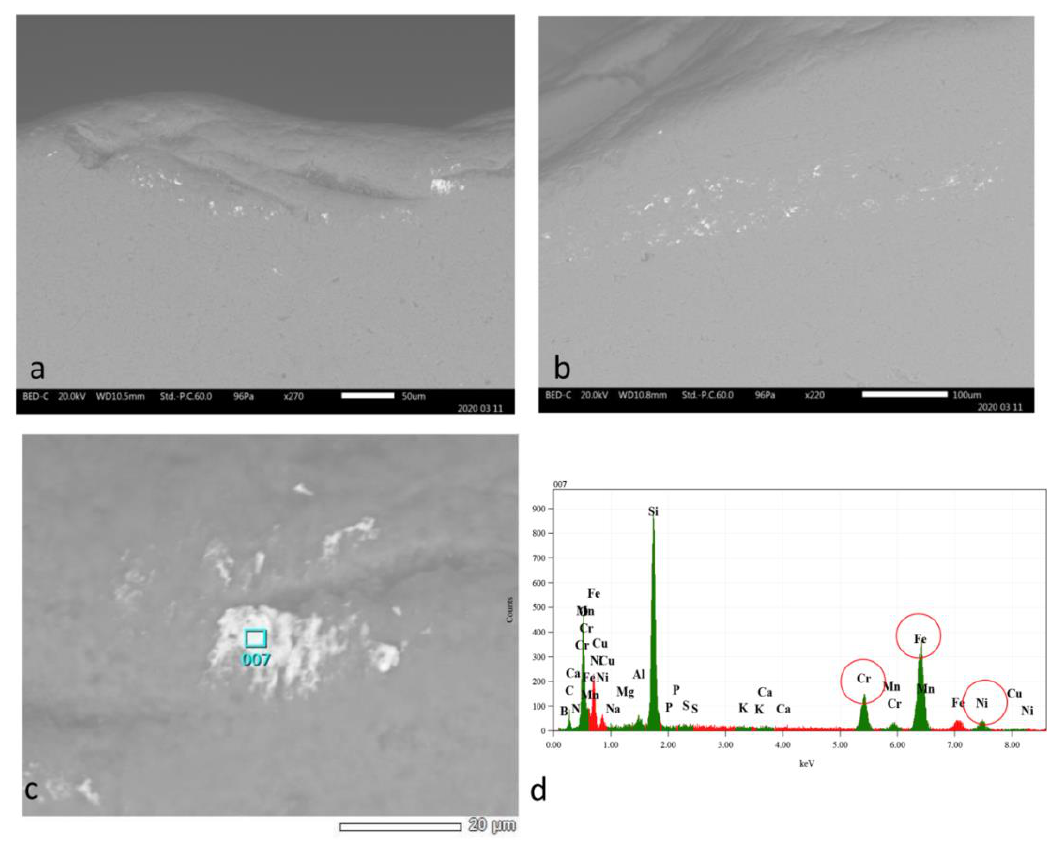
Figure 5. Metal traces: a)+b) backscattered electron images of metal wear on the ventral distal surface of artefact LB25_24; c) detail of the smeared metal deposition with; d) the associated EDS mapping showing that the residue is composed of significant peaks of Iron (Fe), Chroom (Cr) and Nikkel (Ni).